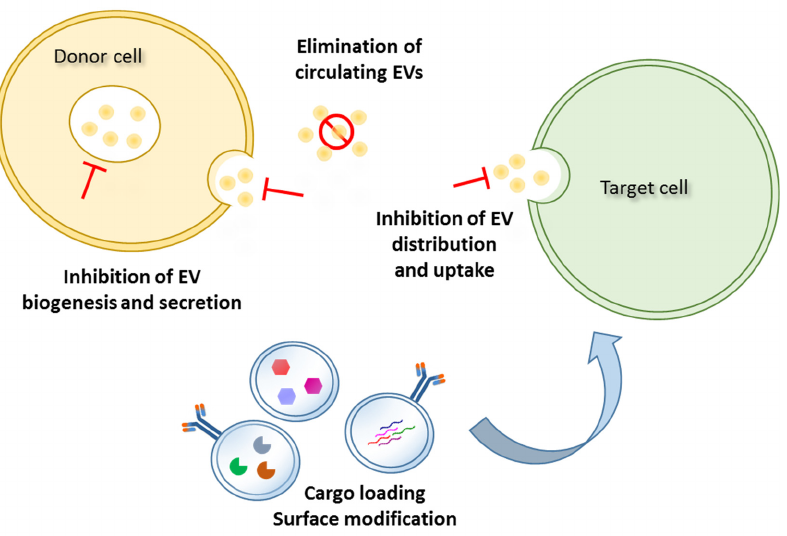
Figure 2. Schematic representation of EV-based strategies for CSC targeting and anticancer therapies.